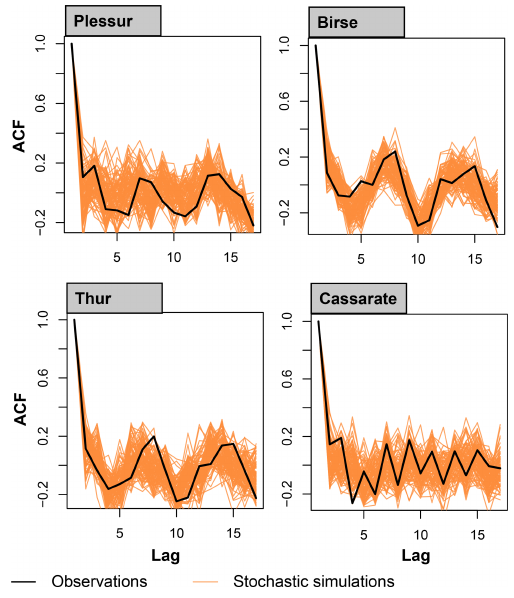
Figure 5. Autocorrelation (ACF) of annual streamflow sums of the observed and simulated streamflow time series for the catchments Plessur, Birse, Thur, and